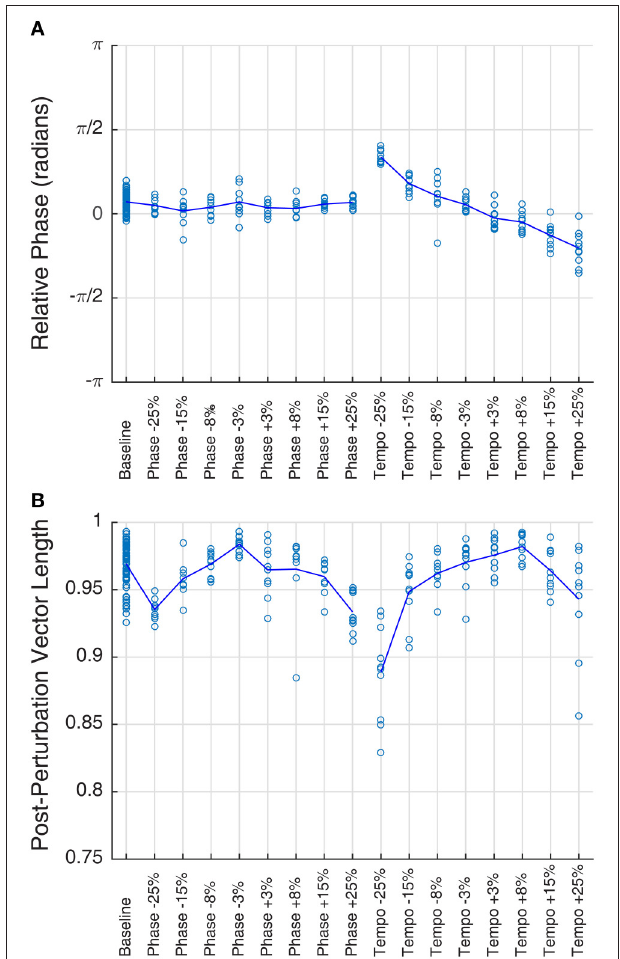
FIGURE 2 | Mean phase (A) and vector length (B) of Ronan’s post-perturbation bobs at a base tempo of 85 bpm, grouped by condition. Each trial is plotted as a circle, and the mean for each condition is represented by the line. Mean phase shows a linear trend with tempo changes (right portion of plot A ), a trend described in a prior study of Ronan’s rhythmic entrainment ability ( Cook et al., 2013). In all cases, mean vector length falls between 0.88 and 0.99, indicating a very high concordance of phases within the